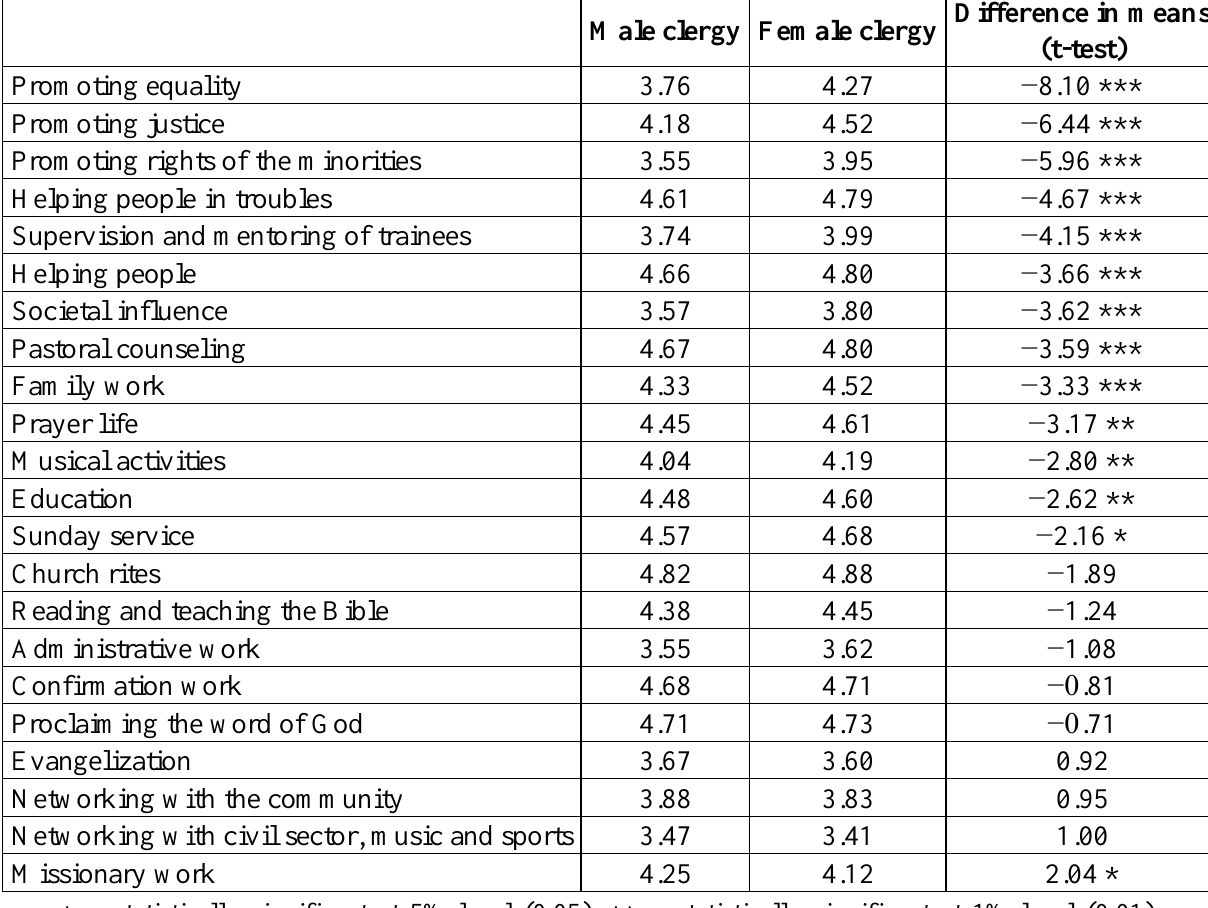
Table 1. Differences between male and female clergy in work orientation. Importance of various aspects of work on a scale 1 to 5 (1 = not important at all, 5 = very important). N =